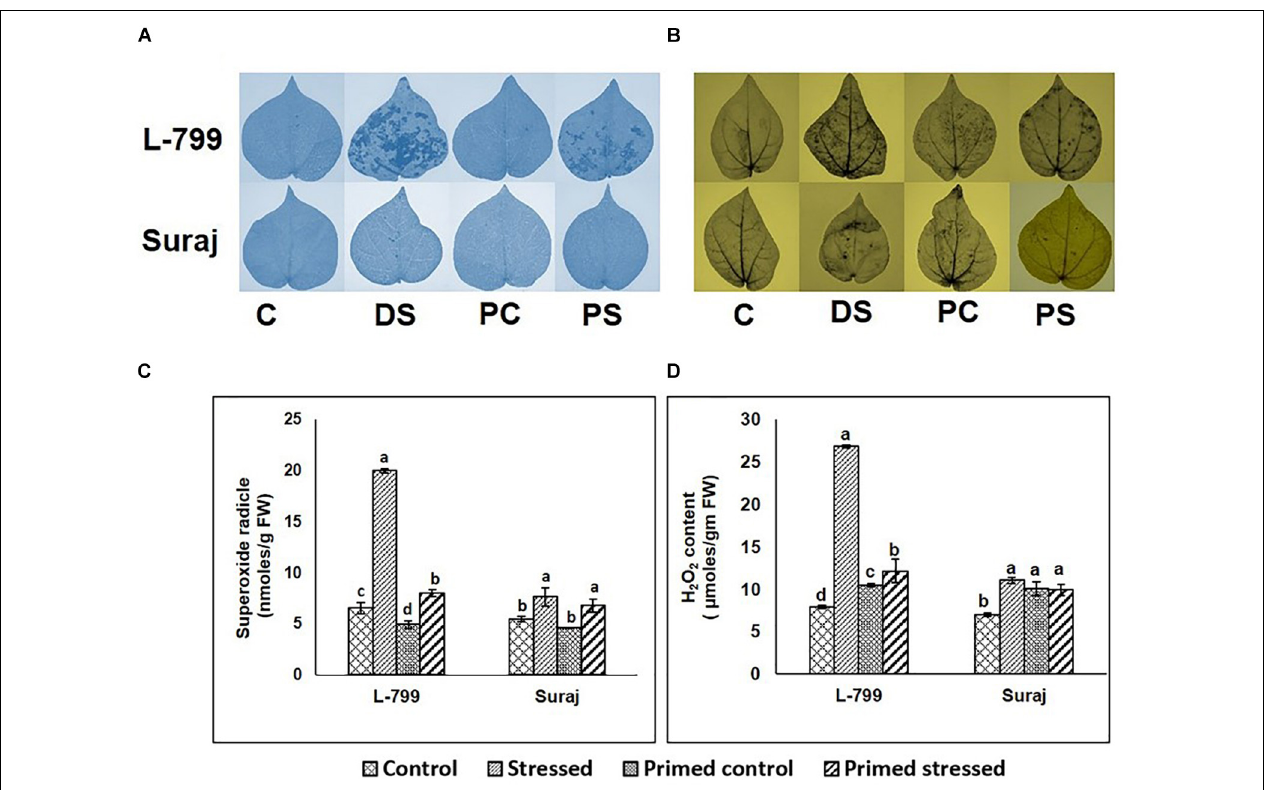
FIGURE 2 | Effect of melatonin on the accumulation of superoxide radicals and hydrogen peroxide in the leaves of drought-sensitive and -tolerant varieties after different treatments. (A,B) Superoxide radical and hydrogen peroxide accumulation in the leaves of different treatments visualized by NBT and DAB staining, respectively, and (C,D) Quantification of superoxide radicals and hydrogen peroxide levels in leaves of drought-sensitive and -tolerant varieties. C, Plants grown under optimal conditions (control). DS, Plants grown by withholding water for 8 days (drought stressed). PC, Melatonin primed plants grown under optimal conditions (primed control). PS, Melatonin primed plants grown by withholding water for 8 days (primed stress). Data represent mean values ± SD of 3 independent experiments, with 3 replicates per treatment in each experiment. Different alphabets within the group represent significant differences among the treatments according to Duncan multiple range test at P <